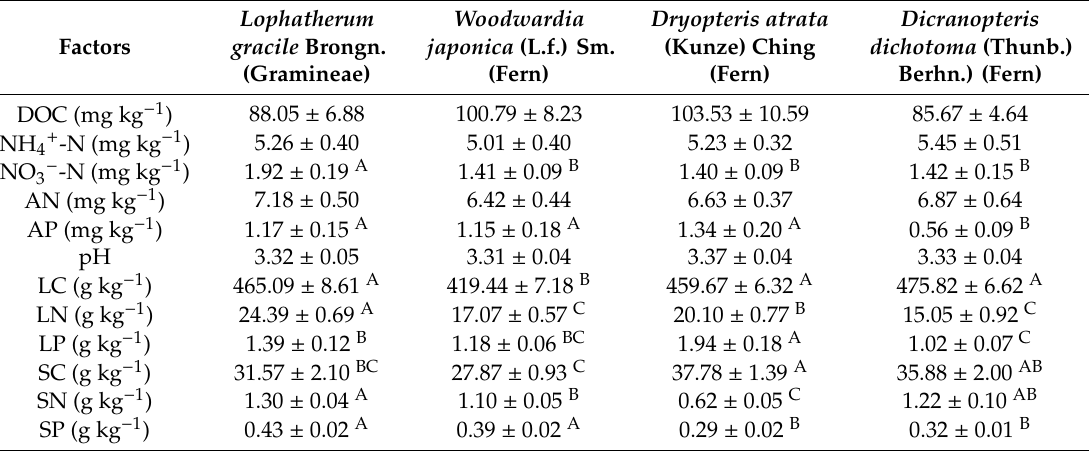
Table 1. Litter and soil nutrients of four understory plant species (means ± SE). Superscript letters in the same line indicate a significant di ff erence at p = 0.05 based on LSD (least significant di ff erence) comparison. Lines without letters indicate that the di ff erence is not significant. LC: litter total organic carbon (C); LN: litter total nitrogen (N); LP: litter total phosphorus (P); SC: soil total organic C; SN: soil total N; SP: soil total